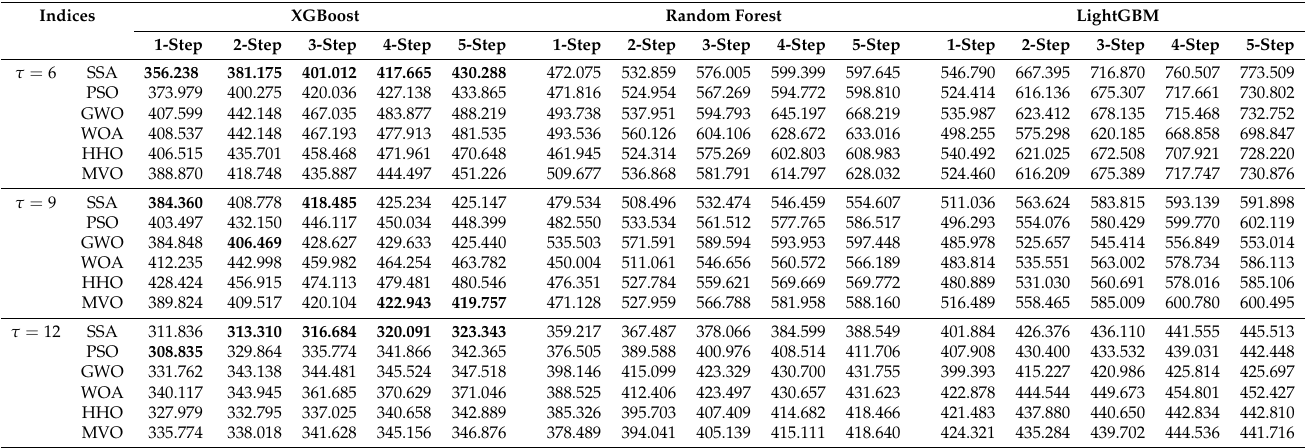
Table 8. RMSEs of multi-step ahead forecasting of the NGC of UK